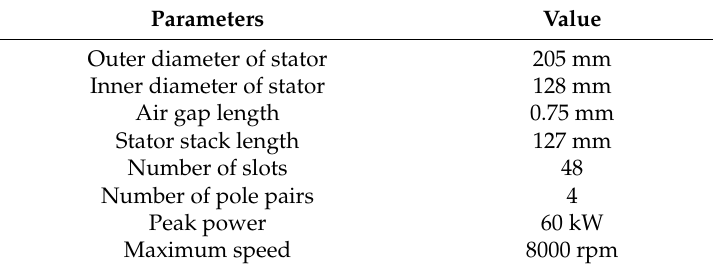
Figure 7. The configuration of the target machine. Table 1. Parameters of the target